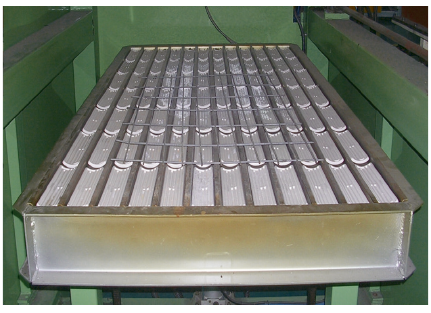
Figure 2: Feature of installed heaters in heating chamber.